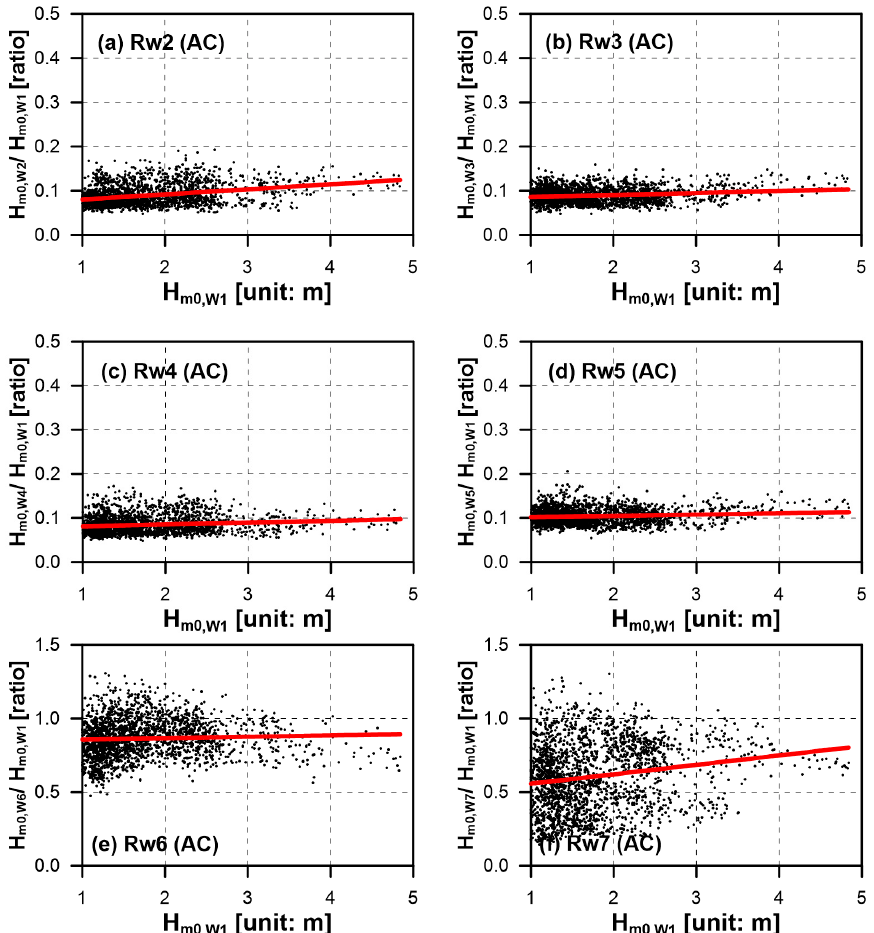
Figure 11. Same as Figure 10, but in AC. ( a ) 𝑅 (cid:3024)(cid:2870) vs. 𝐻 (cid:3040)(cid:2868) , ( b ) 𝑅 (cid:3024)(cid:2871) vs. 𝐻 (cid:3040)(cid:2868) , ( c ) 𝑅 (cid:3024)(cid:2872) vs. 𝐻 (cid:3040)(cid:2868) , ( d ) 𝑅 (cid:3024)(cid:2873) vs. 𝐻 (cid:3040)(cid:2868) , ( e ) 𝑅 (cid:3024)(cid:2874) vs. 𝐻 (cid:3040)(cid:2868) , ( f ) 𝑅 (cid:3024)(cid:2875) vs. 𝐻 (cid:3040)(cid:2868) . The correlation between 𝑅 (cid:3024)# and the wave prop- vs. H m 0 , ( e ) R W 6 vs. H m 0 , ( f ) R W 7 vs. H m 0 . The correlation between R W # and the wave propagation agation direction ( 𝐷 (cid:3043),(cid:3024)(cid:2869) ) observed in Figures 8 and 9 was not found in the case of the wave height ( 𝐻 (cid:3040)(cid:2868) ).